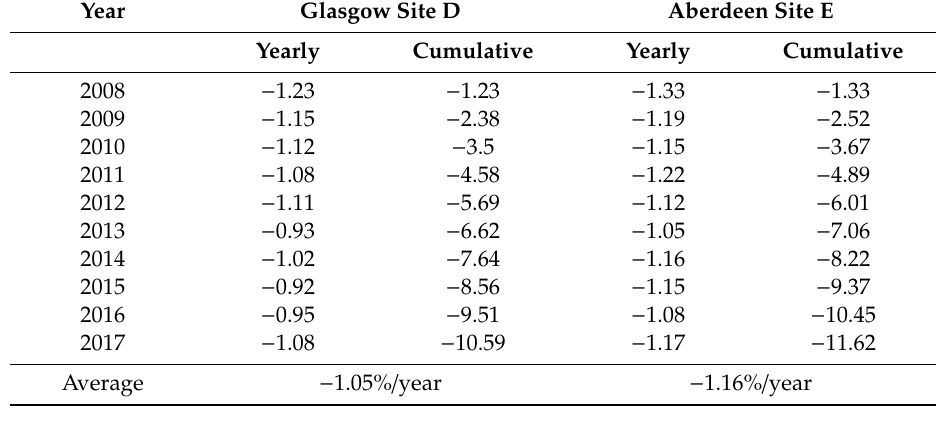
Table 4. Scotland PV systems’ Degradation Rate Analysis.